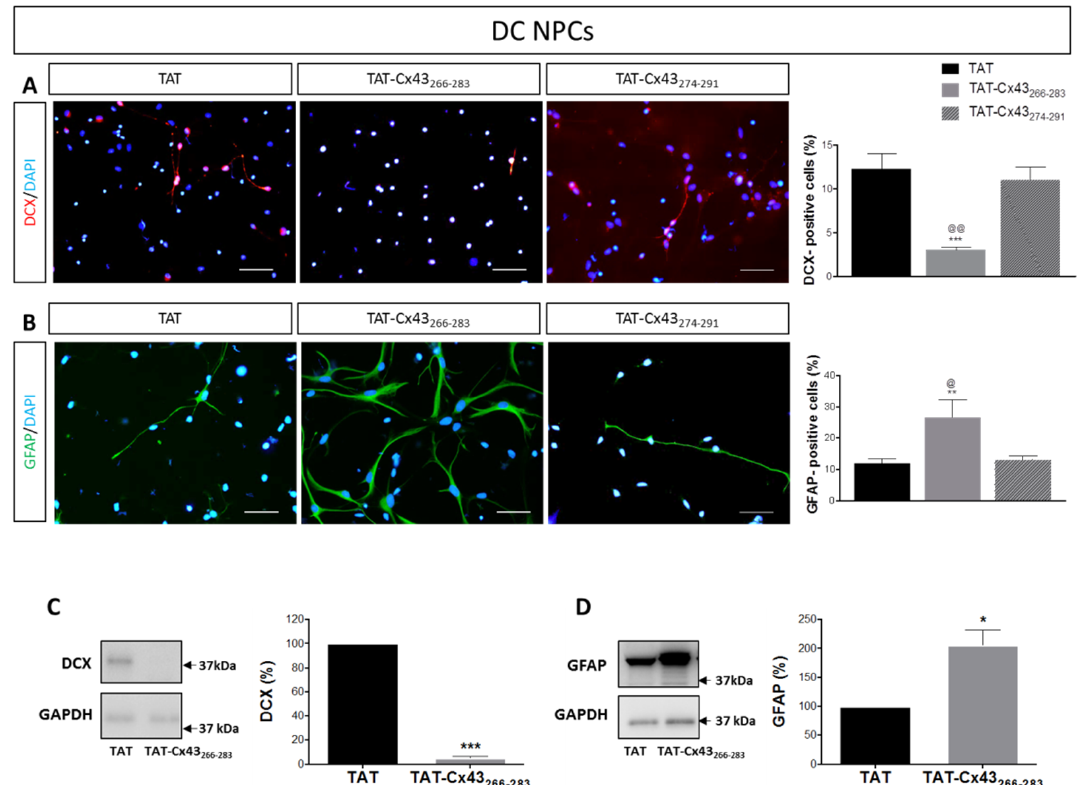
Figure 5. Effect of TAT-Cx43 266-283 on neural progenitor cells in differentiation conditions. ( A , B ) Representative images showing doublecortin (DCX) immunoreactivity (red) and glial fibrillary acidic protein (GFAP) immunoreactivity (green) in neural progenitor cells grown in differentiation conditions (DC NPCs) treated with 25 µM TAT, TAT-Cx43 266-283 , or TAT-Cx43 274-291 for 96 h. Cell nuclei are labeled with DAPI (blue). Bar: 50 µm. Bar graphs show the percentage of DCX-positive and GFAP-positive cells after 96 h of treatment in each experimental condition. Results are the mean ± SEM ( n = 9 TAT, n = 4 TAT-Cx43 266-283 , n = 3 TAT-Cx43 274-291 ; *** p < 0.001, ** p < 0.01 vs. TAT; @@ p < 0.01, @ p < 0.05 vs. TAT-Cx43 274-291 ; ANOVA, followed by Hom Sidak). ( C , D ) Total DCX and GFAP levels were analyzed by Western blot in DC NPCs treated with 25 µM TAT or TAT-Cx43 266-283 for 96 h. Results were normalized against GAPDH and are expressed as percentage with respect to TAT (mean ± SEM,